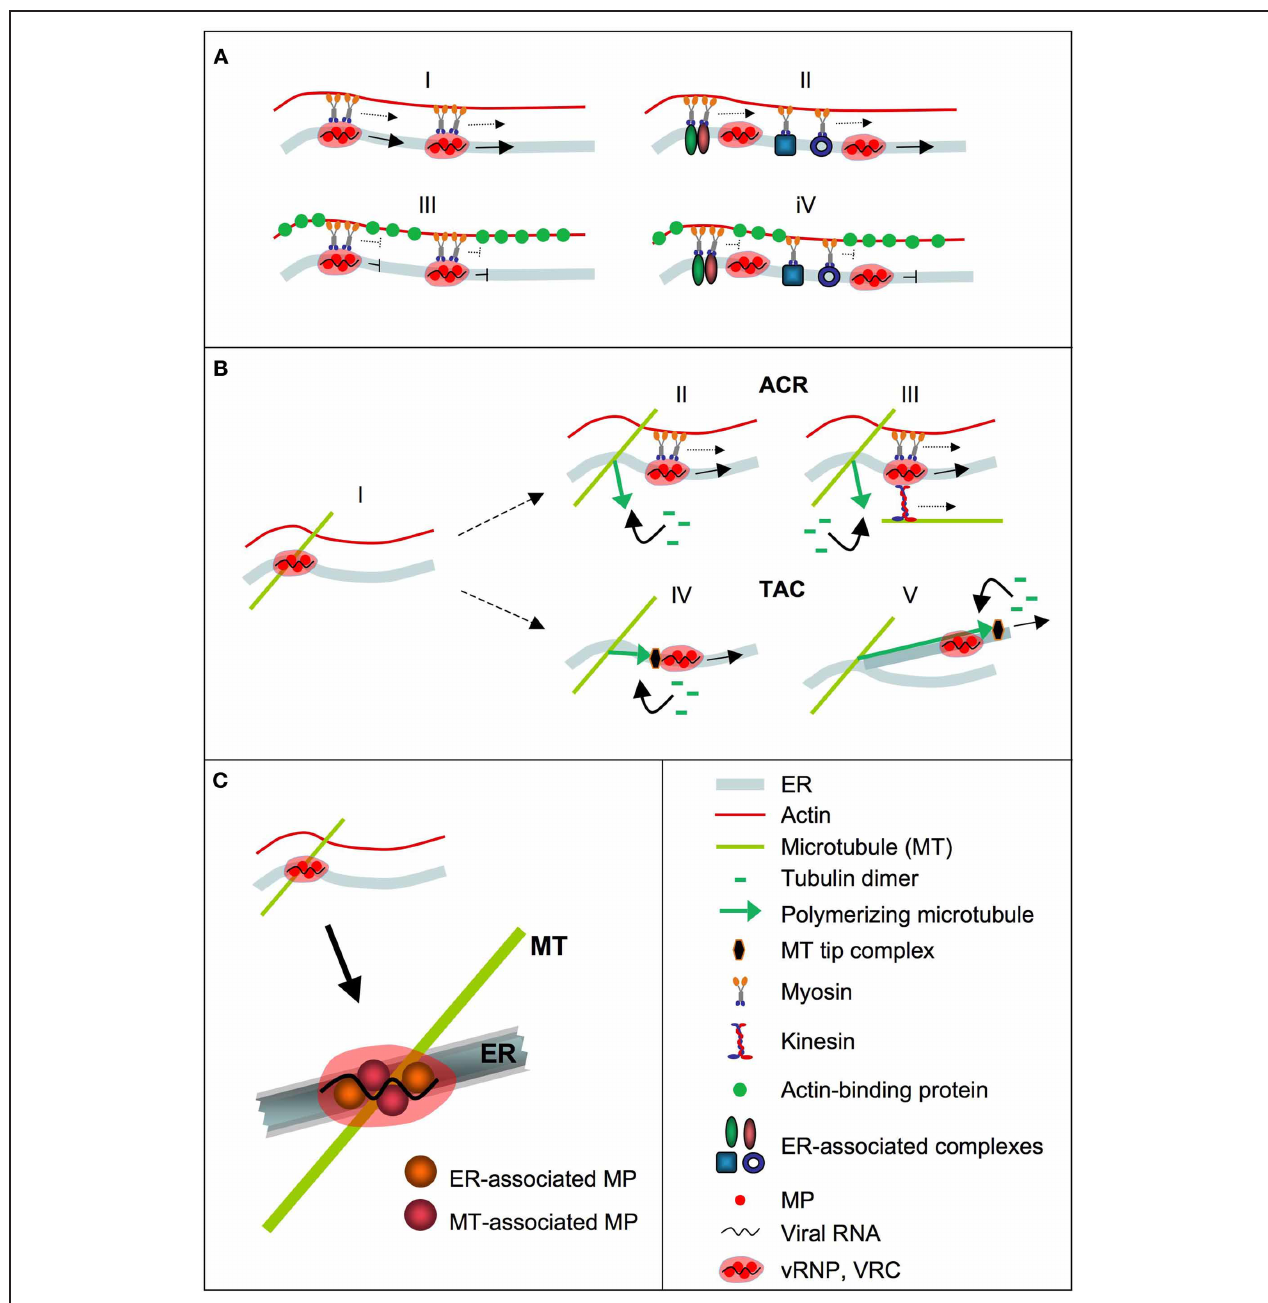
FIGURE 2 | Mechanisms in ER-mediated vRNA transport. vRNA is depicted in the form of a VRC. (A) Role of the ER-associated actin cytoskeleton in VRC transport. ER-associated VRCs may represent cargo for myosins that transport the VRCs along the ER in an actin-dependent manner (I). Transport of VRCs along the ER may also be facilitated by myosin-driven macromolecular mass flow along the membrane (II). Overexpression of actin-binding protein interferes with myosin movements along actin filaments and therefore with myosin-supported VRC transport along the membrane (III and IV). Disruption of actin interferes with the ability of myosins to facilitate directional transport but does not completely abolish VRC transport along the membrane (not shown). (B) Role of microtubules (MT) in